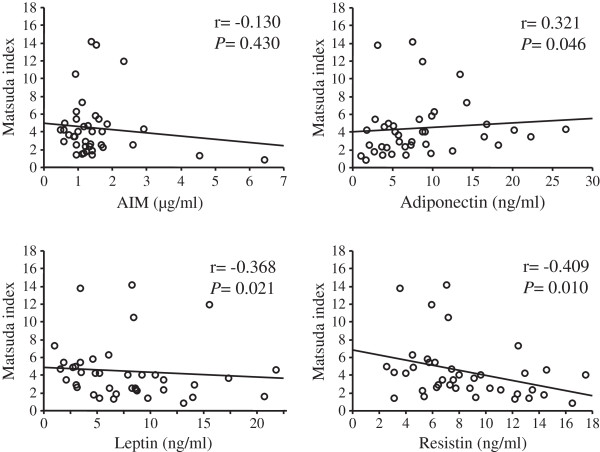
Correlation between serum levels of AIM, adiponectin, leptin, or resistin and WBISI. Serum AIM levels were not correlated with WBISI, but serum adiponectin levels were positively and serum resistin and leptin levels were negatively correlated with WBISI. AIM, apoptosis inhibitor of macrophage; WBISI, whole body insulin sensitivity index
[19]. Correlation coefficients were calculated by Spearman’s rank correlation analysis.